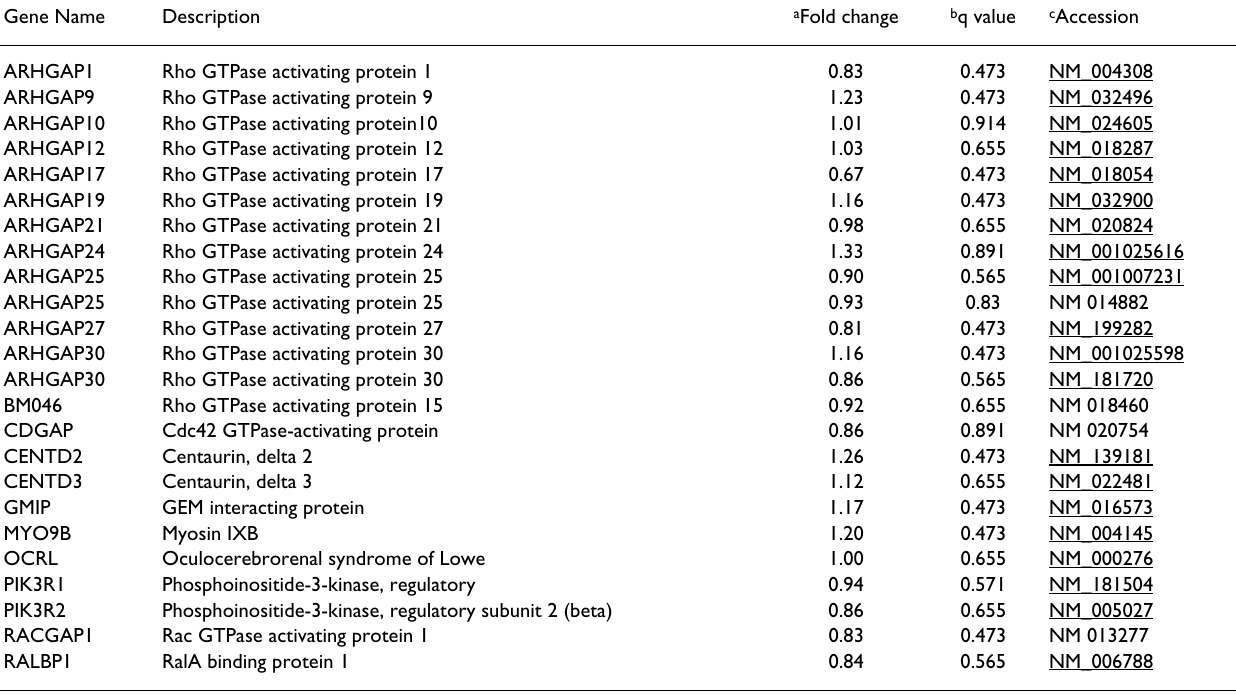
Table 4: RhoGAP family gene expressions in PBMC lacking ARHGAP4 Gene